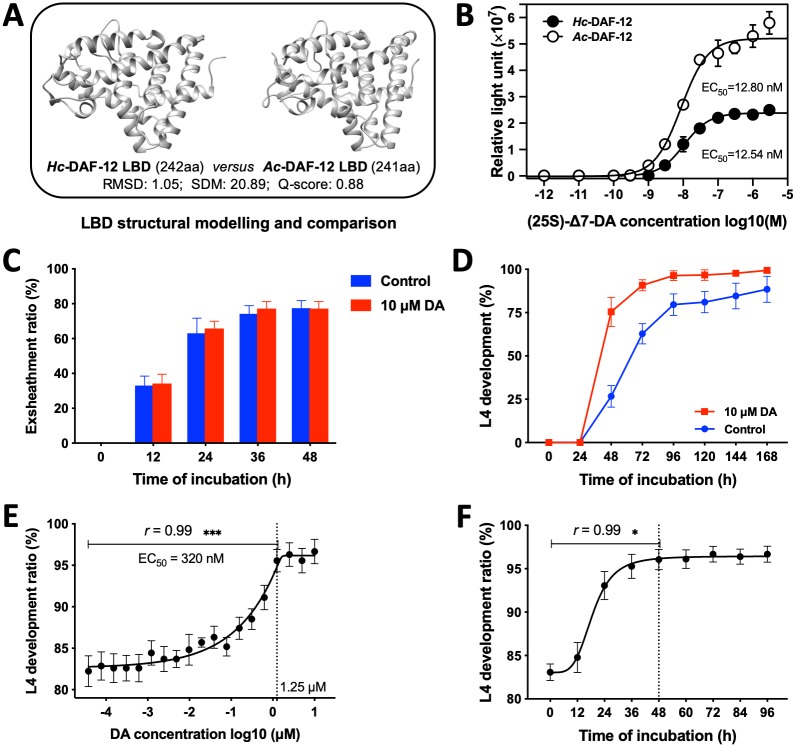
The influence of (25S)-Δ7-DA on larval activation and development.(A) Comparison of the ligand-binding domain (LBD) of DAF-12 of Haemonchus contortus (Hc-DAF-12) with that of Ac-DAF-12 from Ancylostoma caninum, using the following parameters: sequence length, root-mean-square deviation (RMSD), structural distance measure (SDM) and Q-score. (B) Activation of Hc-DAF-12 and Ac-DAF-12 by (25S)-Δ7-DA) in a luciferase reporter assay. The effects of 10 μM of (25S)-Δ7-DA on (C) larval exsheathment and (D) larval development. The effect of (25S)-Δ7-DA on larval development is both (E) dose- and (F) time- dependent. An error bar indicates a standard deviation (SD; four replicates). Statistical significance is indicated with one or more asterisks (*P < 0.05, **P < 0.01, ***P < 0.001, using Student’s t-test).